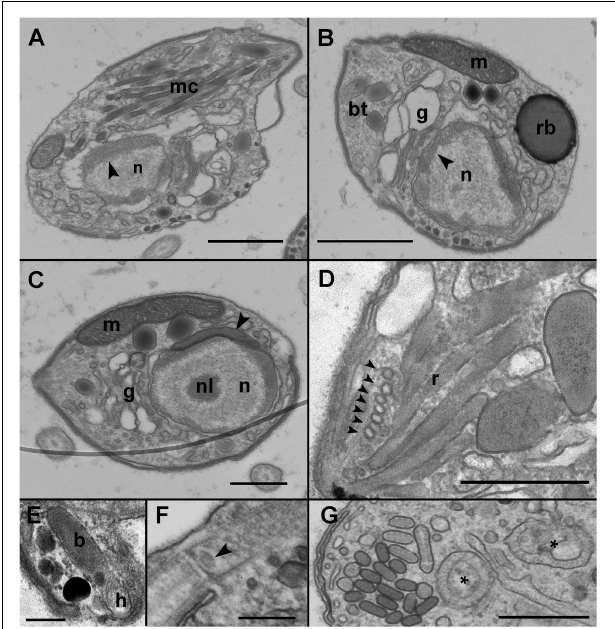
FIGURE 6 | Transmission electron microscopy (TEM) micrographs showing the general features of Maranthos nigrum zoospores. (A) Longitudinal section of a zoospore showing the nucleus with heterochromatin in its periphery (arrowhead) and multiple apical complex microtubules. (B) Transverse section of a zoospore. The nucleus, with its heterochromatin (arrowhead), occupies a central position, and the Golgi apparatus is located close to it. The mitochondrion, trichocysts, and the refractile body are located in the periphery. (C) Transverse section of a zoospore showing the heterochromatin and the nucleolus inside the nucleus. An electron-dense structure is located close to the nucleus (arrowhead). The mitochondrion occupies a lateral position and the Golgi apparatus is close to the nucleus. (D) A section of the apical area of a zoospore shows the pseudo-conoid microtubules (arrowheads) and several rhoptries. (E) Detail of a bipartite trichocyst, showing the body and head. (F) Section of a zoospore, showing the basal body of the posterior flagellum, with a dense globule in the transition zone (arrowhead). (G) Detail of undefined bodies present in the zoospore cytoplasm (*). Abbreviations: b = trichocyst body; bt = bipartite trichocysts; g = Golgi apparatus; h = trichocyst head; m = mitochondrion; mc = apical complex